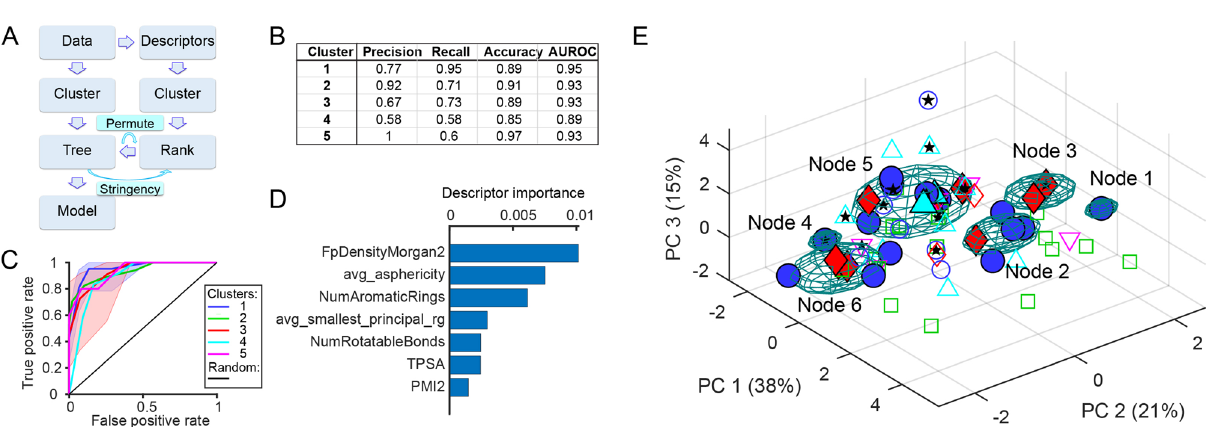
Figure 6. Gnomic model of compound accumulation in P. aeruginosa . ( A ) Gnomic algorithm. ( B ) Performance metrics for the prediction of each cluster. ( C ) Receiver operating curve of the classification model. Shaded area marks the confidence bands for cluster 2. ( D ) Descriptors selected by training the model. ( E ) Distribution of the clusters in the property space. Color coding the same as in Fig.